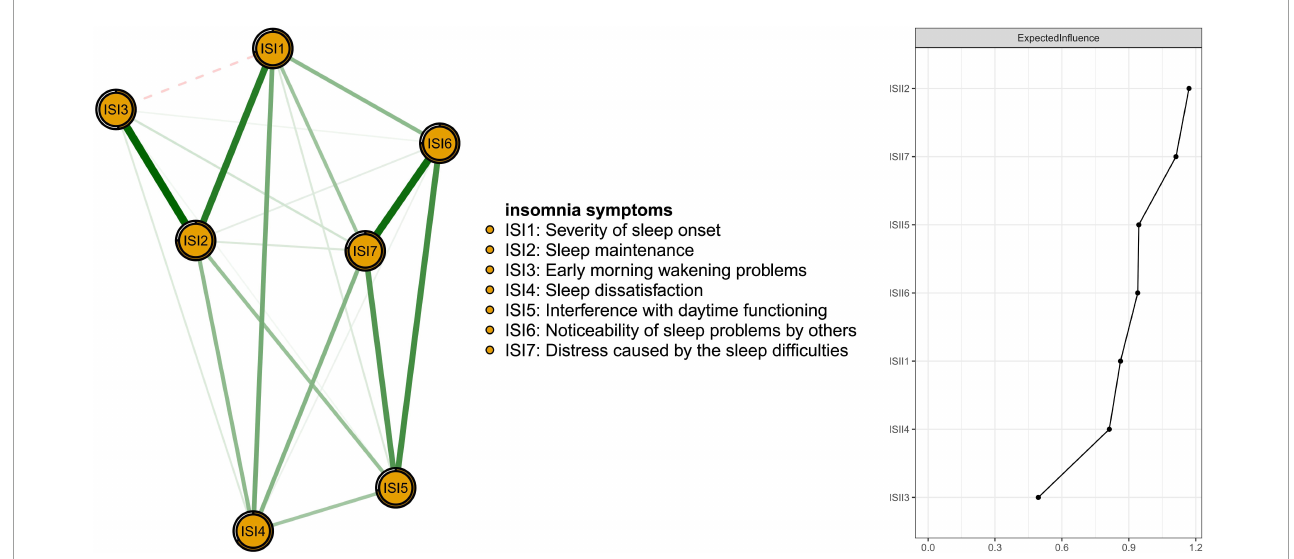
FIGURE1 Network structure of insomnia symptoms among Macau residents during the COVID-19 pandemic.